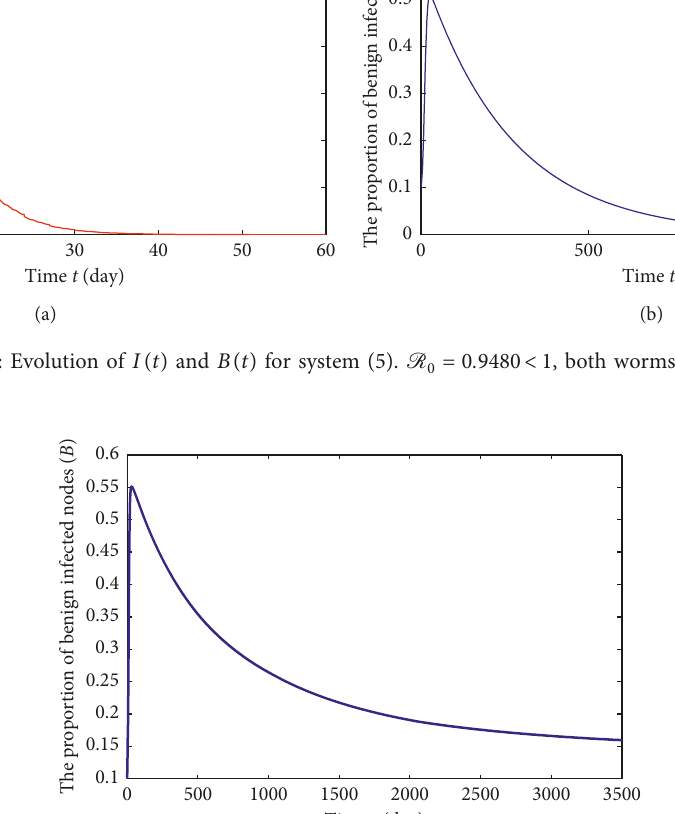
� 1 . 6189 > 1, benign worm is permanent. 1